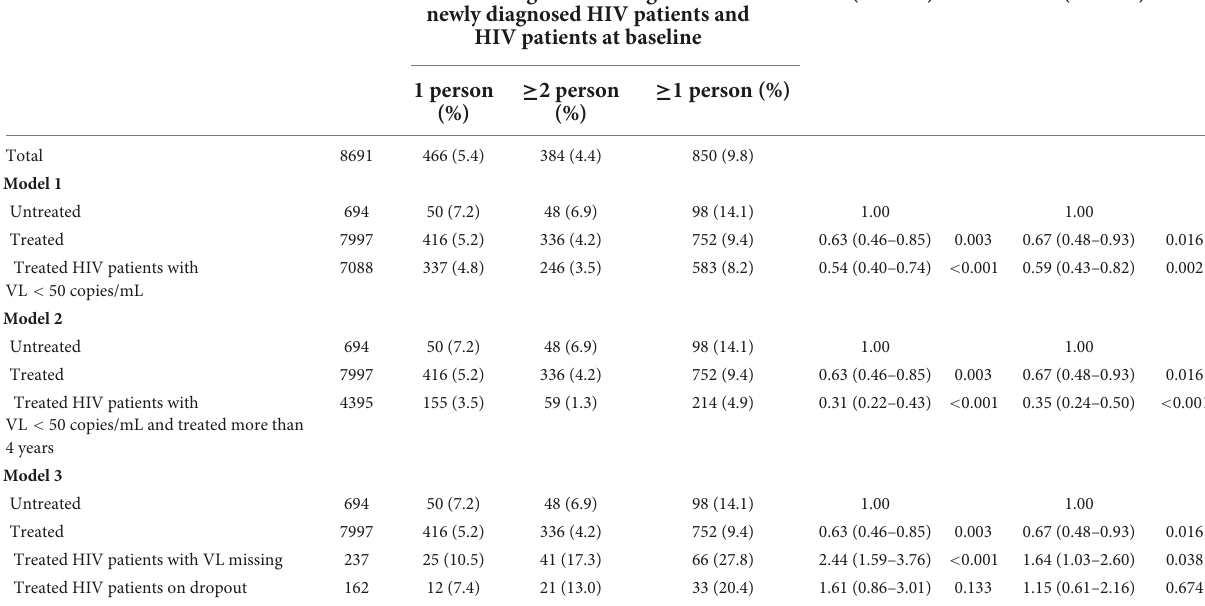
TABLE 3 Genetic linkage between newly diagnosed patients with HIV and those at baseline in Guangxi of China, stratified by treatment, viral load, and follow-up status. OR (95% CI) P AOR (95% Variable Baseline Number of genetic linkages between newly diagnosed HIV patients and HIV patients at baseline